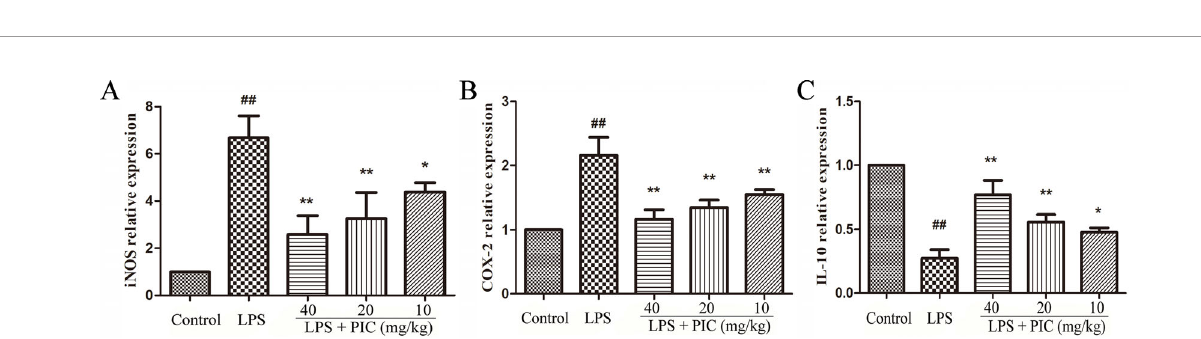
FIGURE 6 | The production of pro-in fl ammatory cytokines in lung tissues. Lung tissues from different groups were gathered and homogenized with phosphate- buffered saline (PBS). The supernatant was used to analyze the concentration of (A) tumor necrosis factor (TNF)- a and (B) interleukin (IL)-1 b using ELISA kits. ## p < 0.01 is signi fi cantly different from the control group; ** p < 0.01 are signi fi cantly different from the lipopolysaccharide (LPS) group.